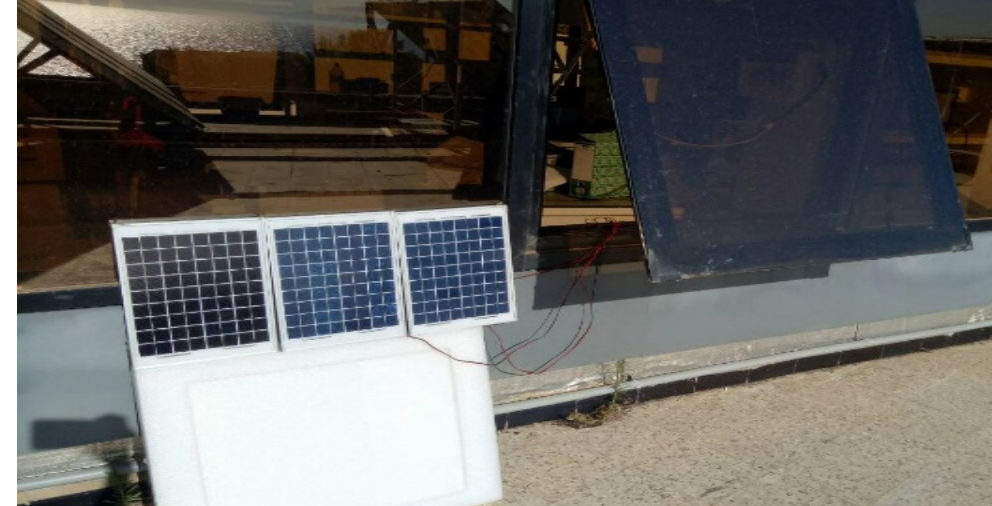
Figure 10. Implementation of the system in the prototype of the solar house on a small scale.